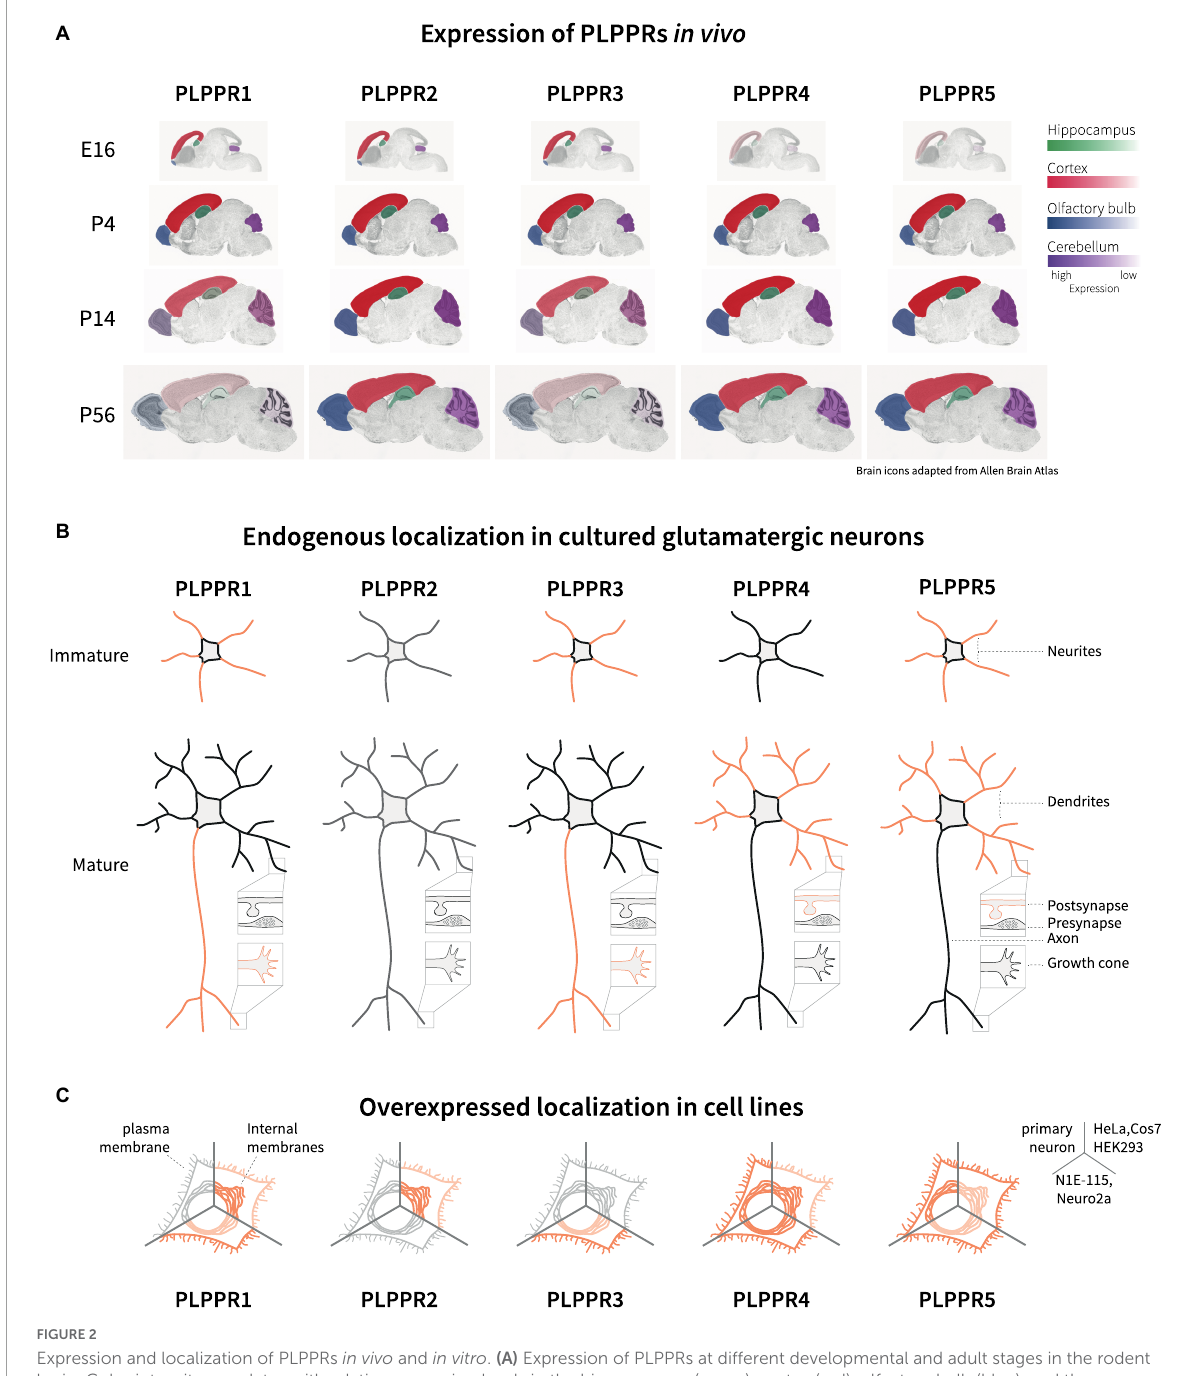
FIGURE2 Expression and localization of PLPPRs in vivo and in vitro . (A) Expression of PLPPRs at different developmental and adult stages in the rodent brain. Color intensity correlates with relative expression levels in the hippocampus (green), cortex (red), olfactory bulb (blue), and the cerebellum (purple). (B) Localization of PLPPRs in different compartments (neurite, dendrite, pre-/post-synapse, growth cone) in cultured hippocampal/cortical neurons. (C) Subcellular localization of tagged-PLPPRs in plasma- and intracellular membrane compartments following overexpression in different cells. For details and references, please refer to